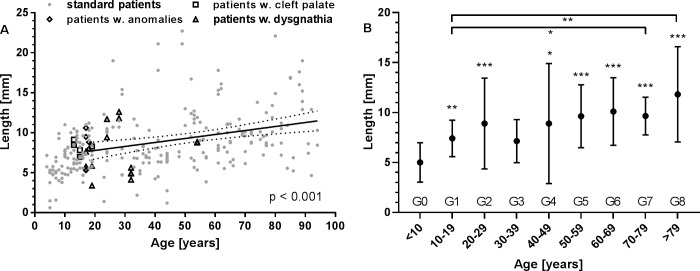
Lengths of the naturally open (air filled) part of the cartilaginous ET.An increase with age can be detected. A: Individual data for all patients. Additionally indicated are values for patients with pre-existing conditions such as cleft palate (□), dysgnathia (△), and anomalies (◇). Best linear fit for all adult patients with normal conditions, its 95% confidence intervals and p-value are provided. B: Group mean values for all patients without pre-existing conditions (mean ± SD). * p < 0.05; ** p < 0.01; *** p < 0.001.